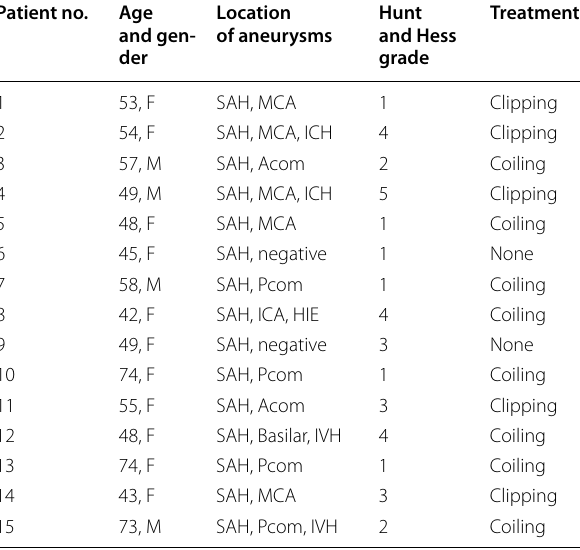
The patients’ age, gender, location of aneurysm, distribution along the Hunt and Hess scale and treatment performed to secure the aneurysm of the fifteen patients taking part on the study SAH subarachnoid hemorrhage, MCA middle cerebral artery, ICH intracerebral hemorrhage, Acom anterior communicating artery, Pcom posterior communicating artery, HIE hypoxic ischemic encephalopathy, IVH intraventricular hemorrhage